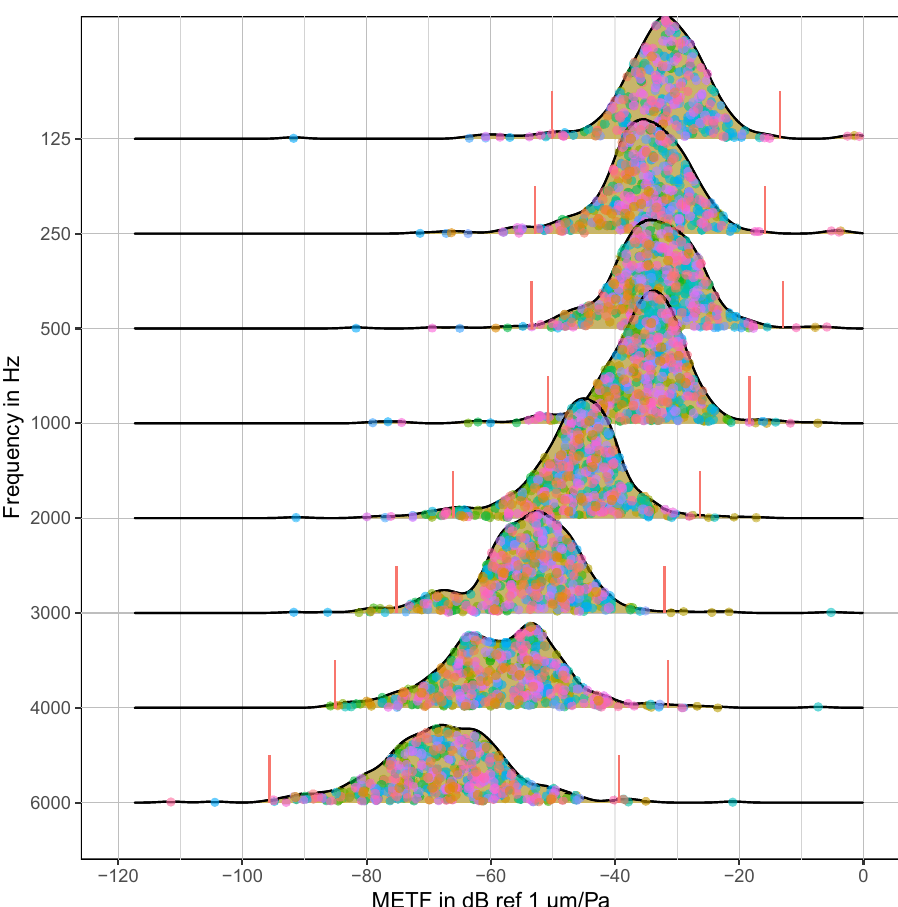
Figure 3. Ridge plot of method “A” METF data. The plot shows continuous probability density functions calculated with kernel density estimation. 1.75xIQR threshold boundaries for outlier detection are marked with red vertical borders. Similar plots for individual groups are included in the supplementary